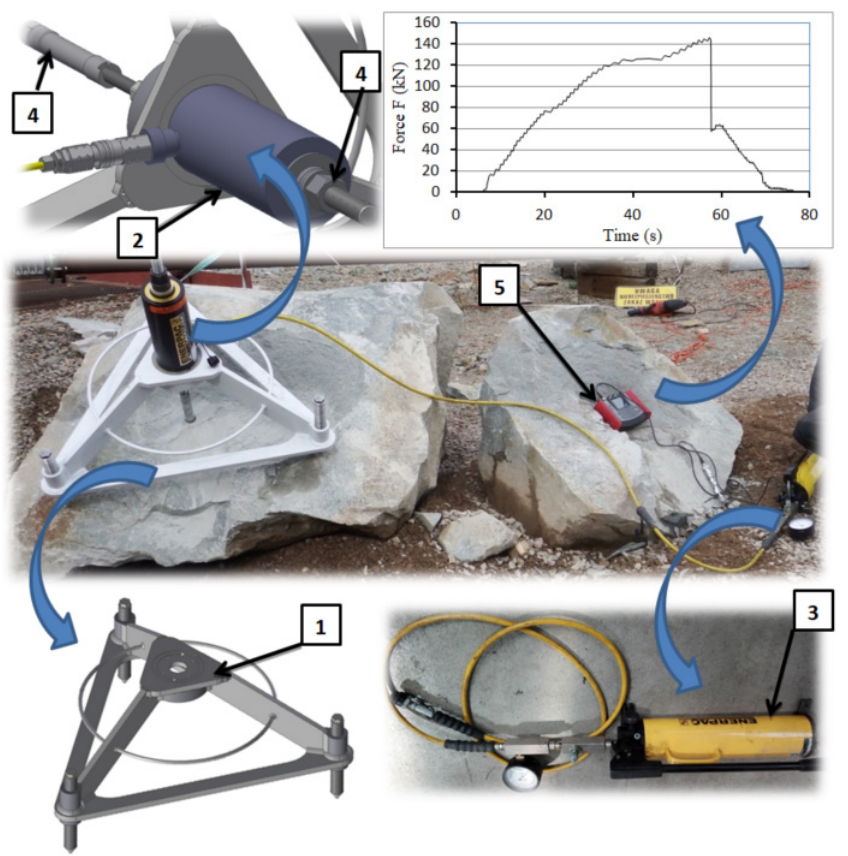
Figure 8: The RODEST test stand equipment As a standard, the testing device is equipped with the following components (Figure